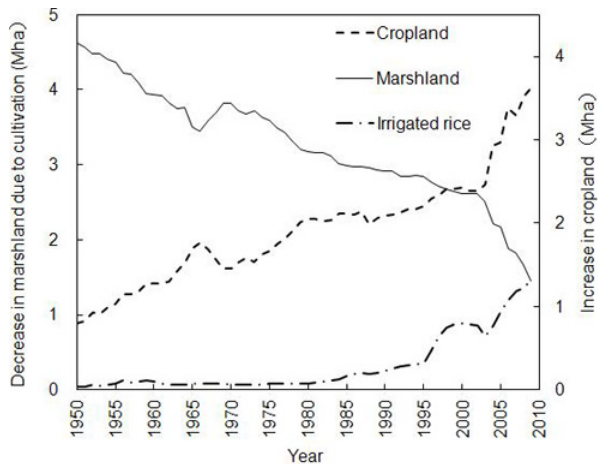
Fig. 2. Conversion of marshland to cropland on the Sanjiang Plain.